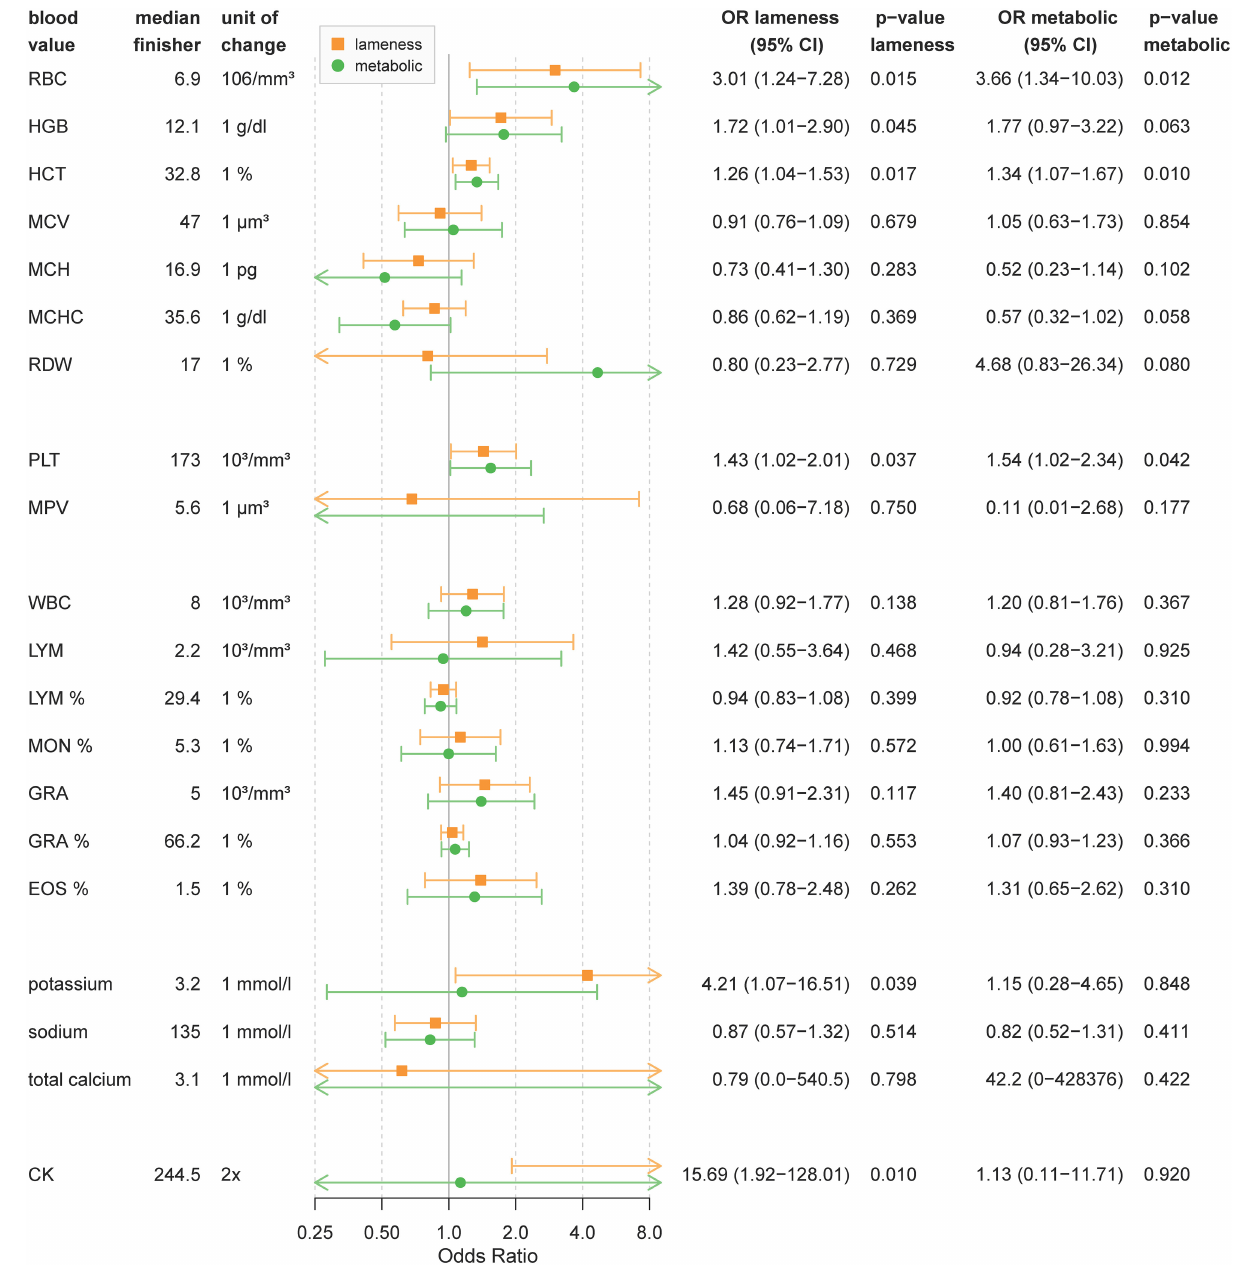
FIGURE 2 | Blood value odds ratios for lameness or metabolic elimination. The figure shows odds ratios for elimination due to lameness or metabolic reasons depending on blood values based on 49 horses. Odds ratio are calculated for changes by one unit of change. OR above 1 mean that the odds of elimination increases with blood values higher than the finisher group. For OR below 1 the odds for elimination is higher for blood values lower than the finisher group. OR are shown as point estimates (circle or square) with 95% confidence intervals as error bars. Orange shows OR for lameness and green show OR for metabolic elimination. P -values below 0.05 can be considered significant. WBC, white blood cells; LYM, absolute lymphocytes; LYM%, relative lymphocytes; MON, absolute monocytes; MON%, relative monocytes (MON%); EOS%, relative eosinophils; GRA, absolute granulocytes; GRA%, relative granulocytes; RBC, red blood cells; HBG,